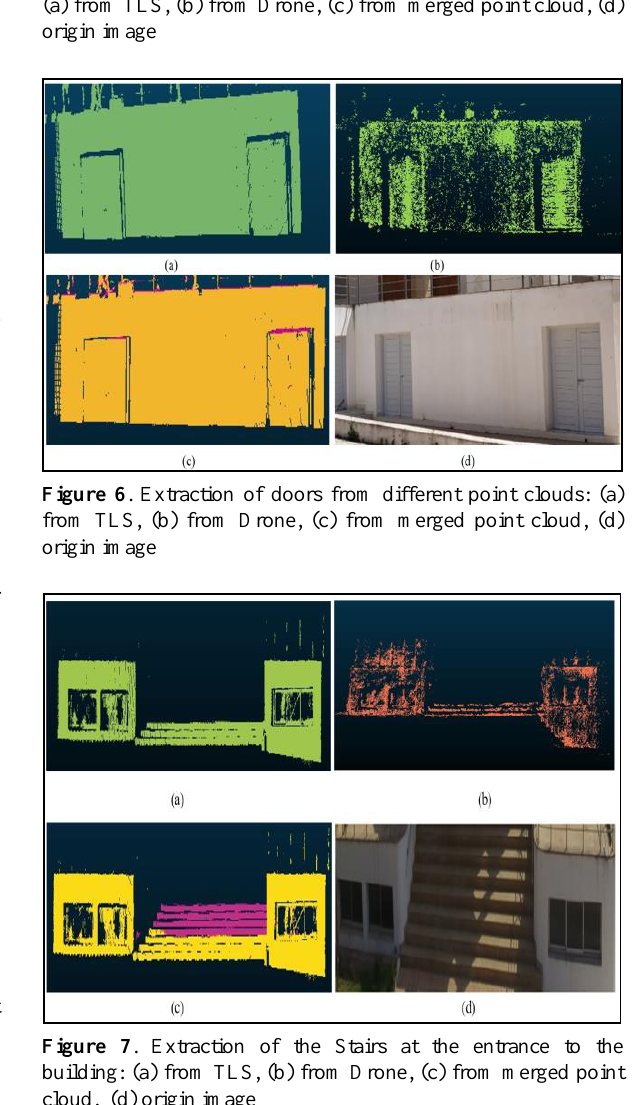
Figure 5 . Extraction of windows from different point clouds: